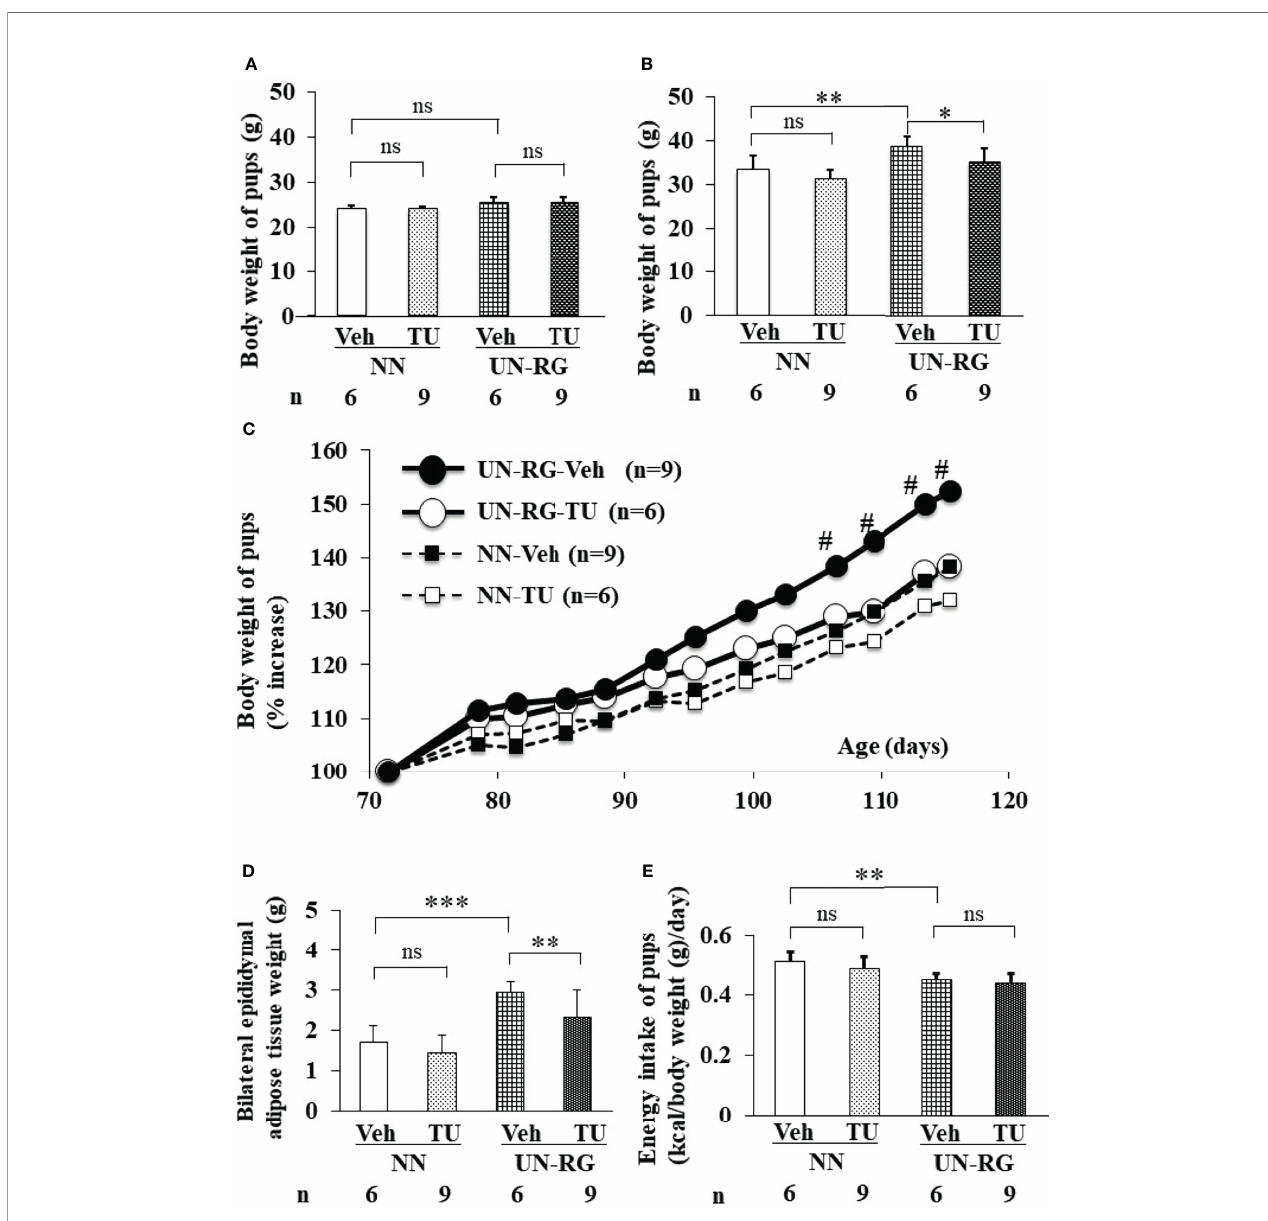
FIGURE 3 | Changes in the body or tissue weight (A – D) and energy intake (E) of pups before (A) and after (B – E) HFD. Body weight [ (A) ; 9 wks] [ (B) ; 16.5 wks] [ (C) ; 9-16.5 wks],, epididymal adipose tissue weight [ (D) ; 16.5 wks), and energy intake [ (E) ; 15 wks]. Tissue sampling was performed at 16.5 wks. # P < 0.01 vs NN- Veh. *P < 0.05; **P < 0.01; ***P < 0.001. NS, no statistical signi fi cance. Means of the data were plotted (C)